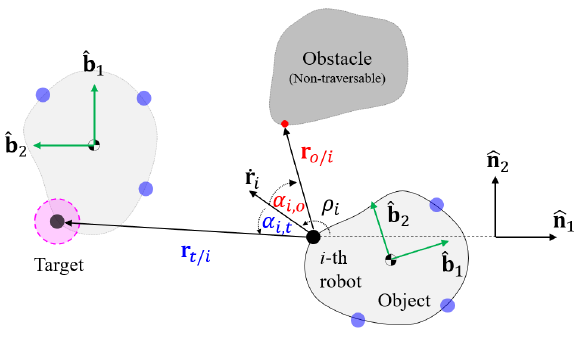
Figure 3. Definitions of FIS-related